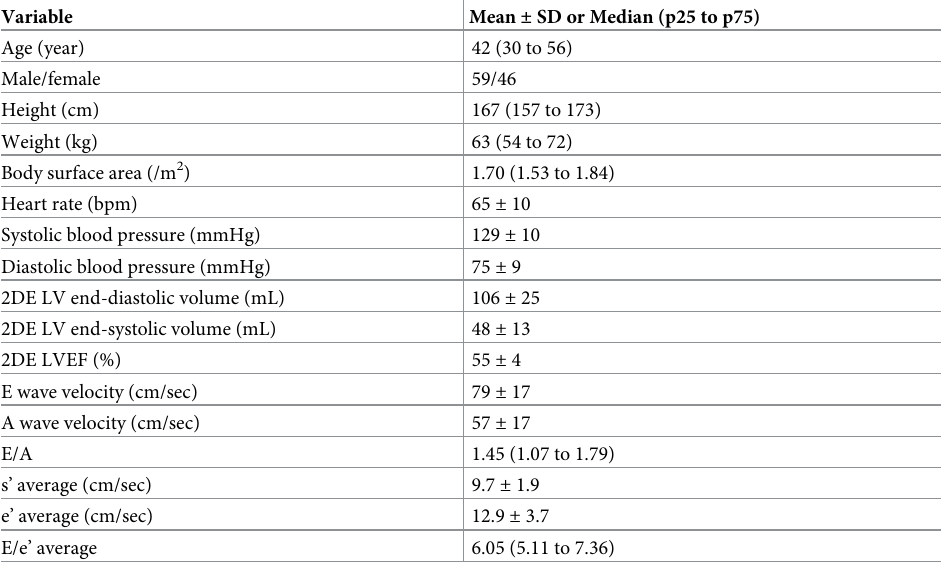
Table 1. Clinical and echocardiographic characteristics in 105 normal